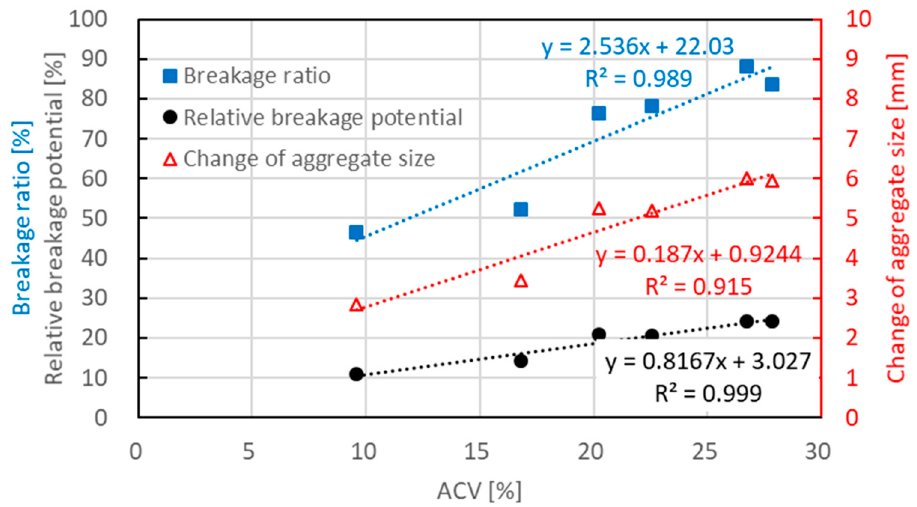
Figure 6. Relations of breakage ratio, change of aggregate size and relative breakage potential to